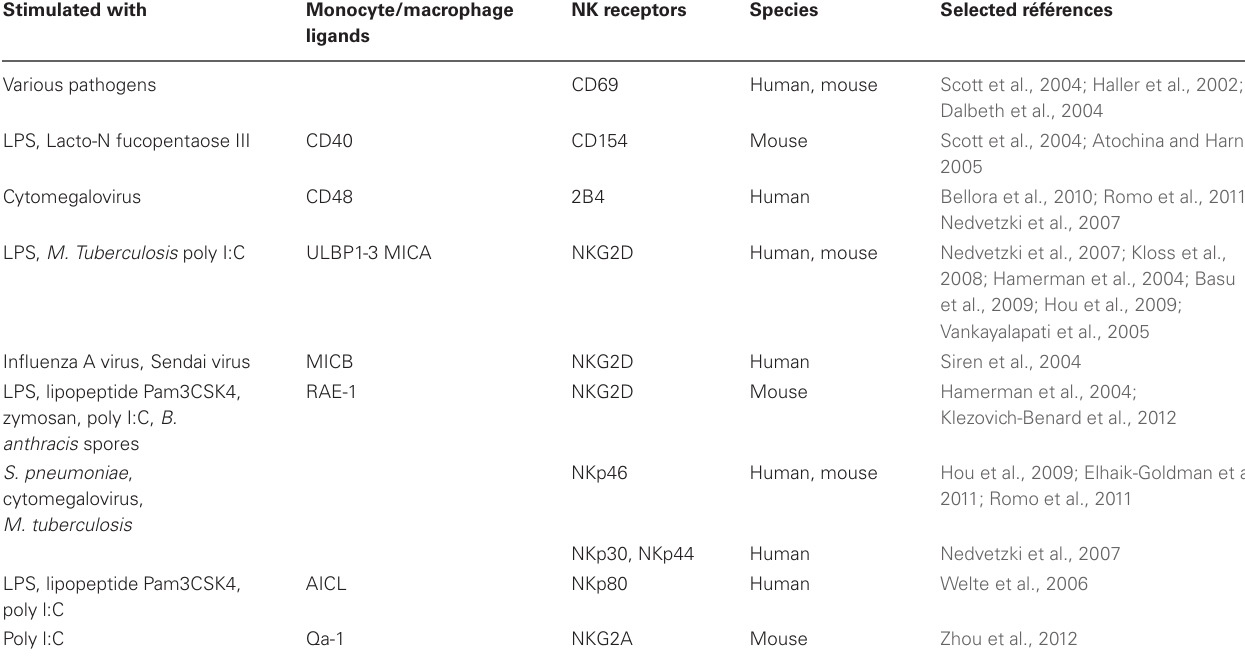
Table 1 | Ligand-receptor families implicated in activation of NK cells by monocytes/macrophages. Stimulated